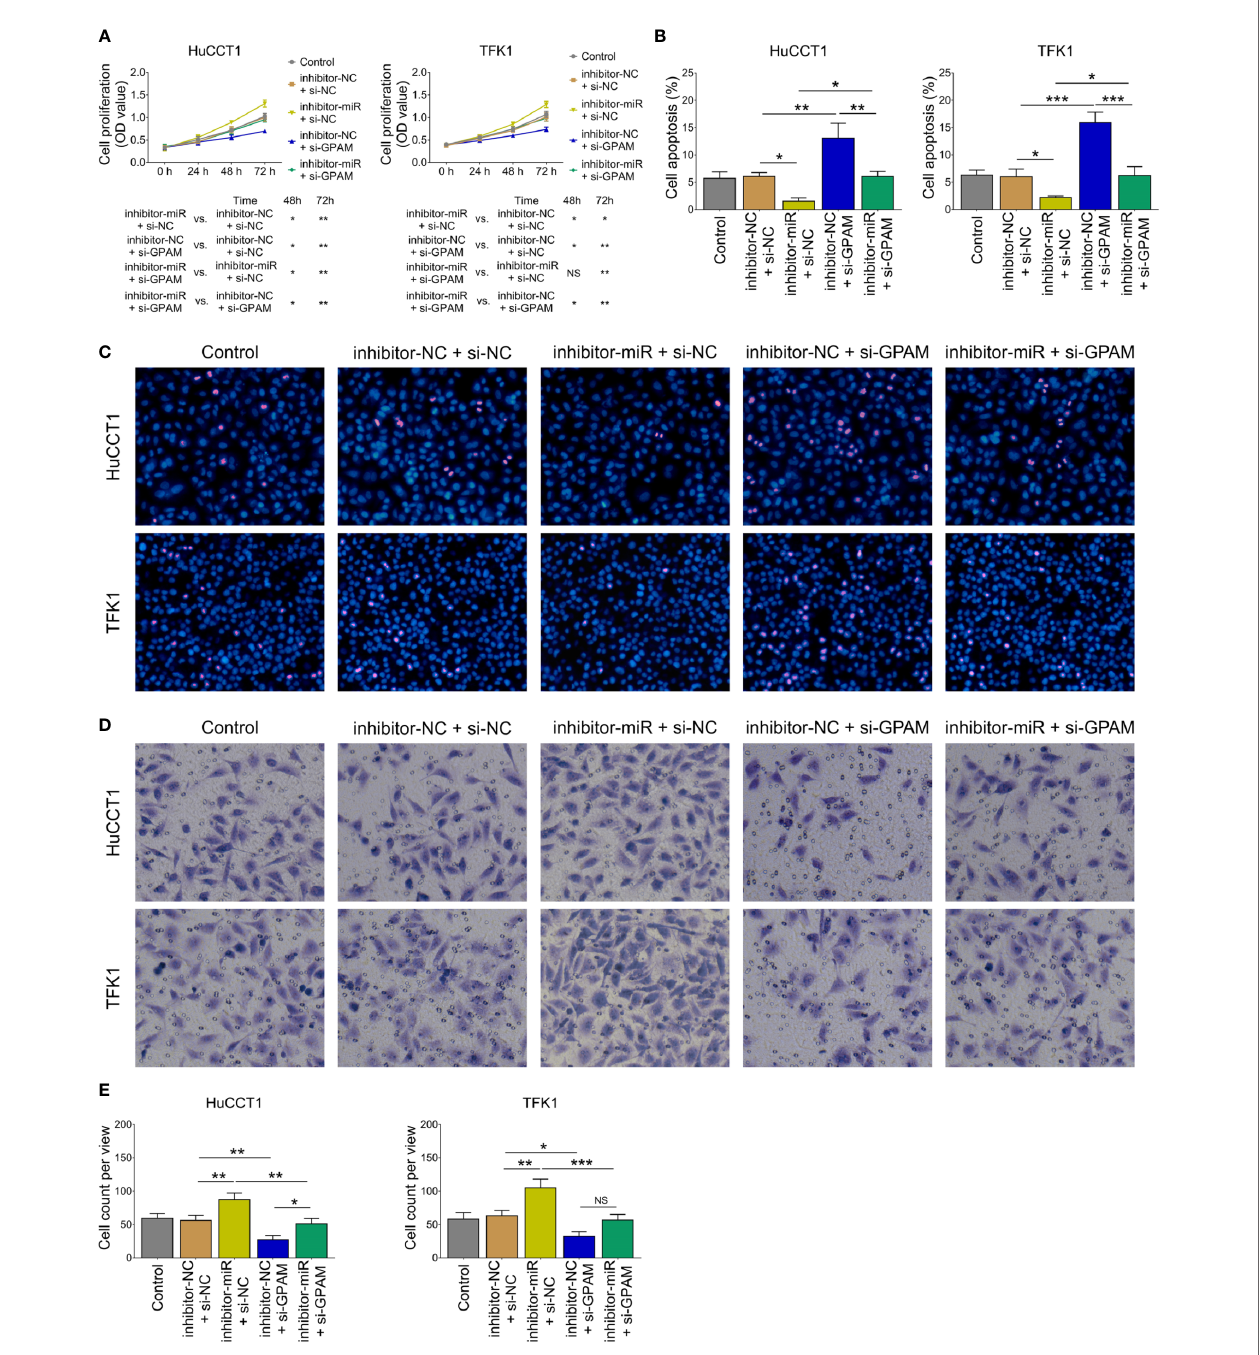
FIGURE 7 | Effect of GPAM knockdown on cell proliferation, apoptosis, and invasion in CCA cell lines. Cell proliferation (A) , cell apoptosis rate (B) , TUNEL image examples (C) , Transwell image examples (D) , and invasive cell count (E) among groups after transfection. NS, not signi fi cant; * P < 0.05; ** P < 0.01; *** P <